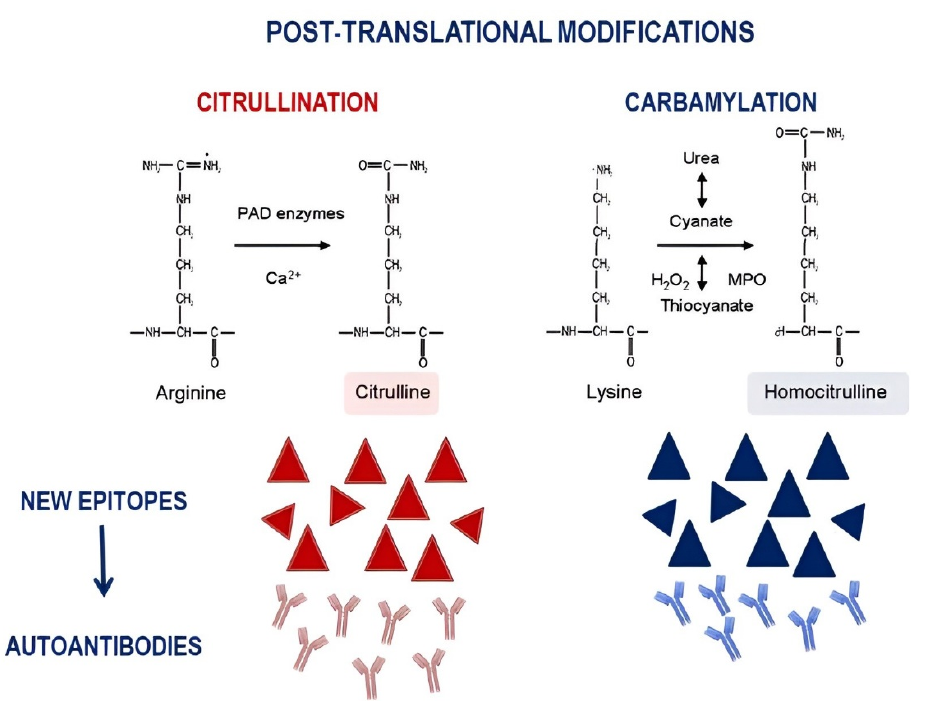
Figure 2. Summary of post-translational modification involved in the production of autoantibodies directed against citrullinated and carbamylated proteins.